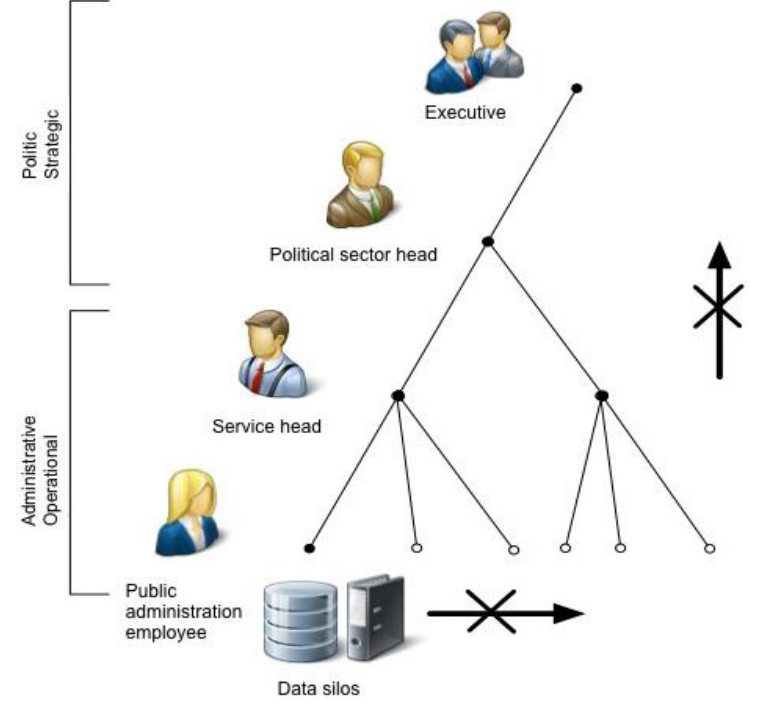
Figure 3. Current Figure 3. Current situation.